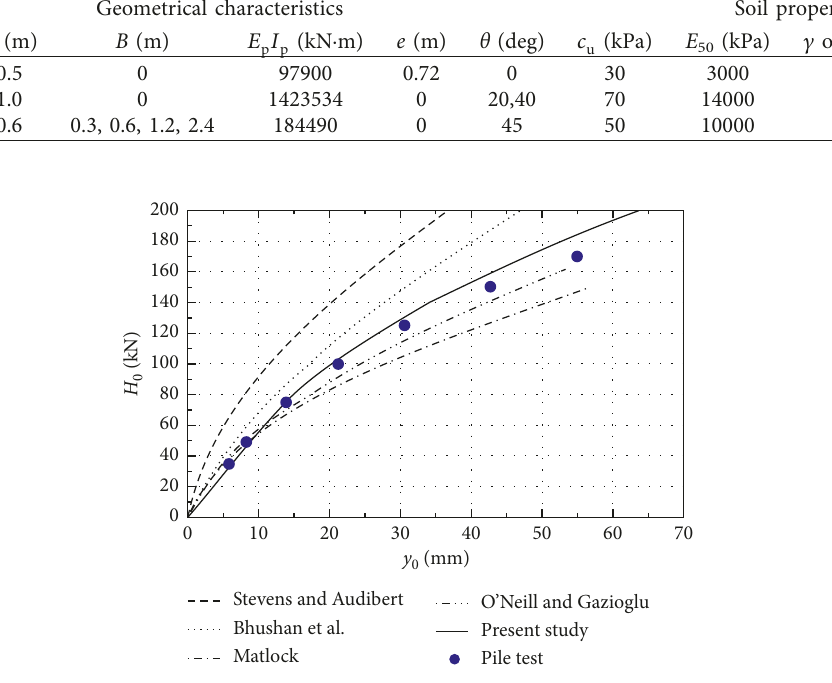
Figure 6: Verification analysis of H 0 - y 0 curves relationship for Shanghai pile tests.